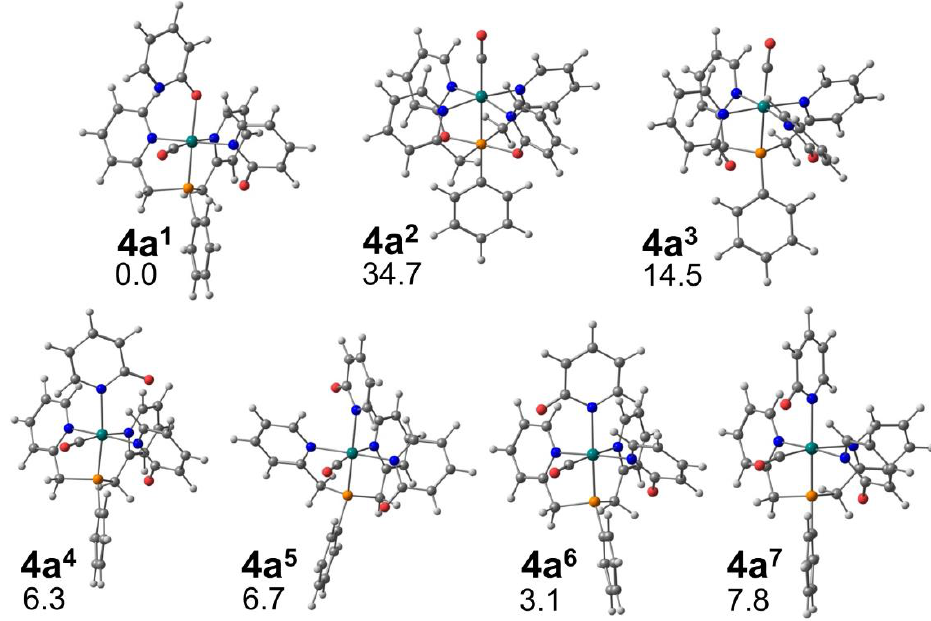
Figure 8. Seven different isomers of compound 4a and their relative Gibbs free energy values in kcal mol − 1 at 293.15 K. at 293.15